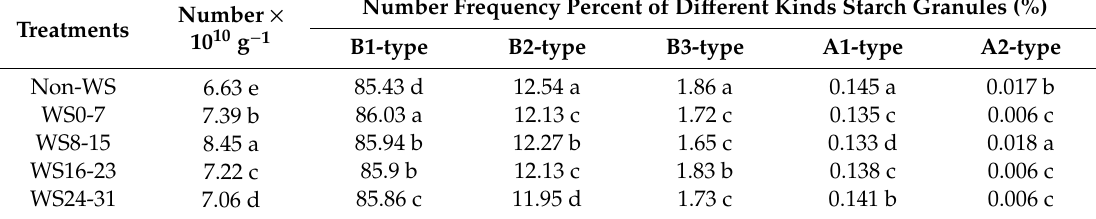
Table 4. E ff ect of combined waterlogging and shading stress during post-anthesis on number frequency percent distribution of di ff erent kinds of starch granules in wheat grains at maturity.